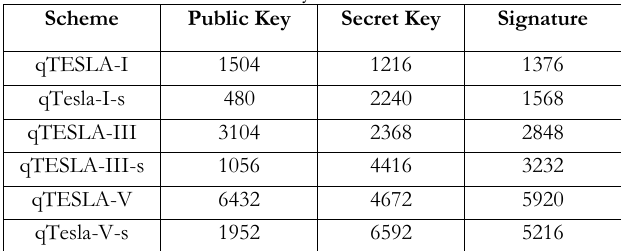
Table 7. Second Round AVX2 Implementation Key Sizes in